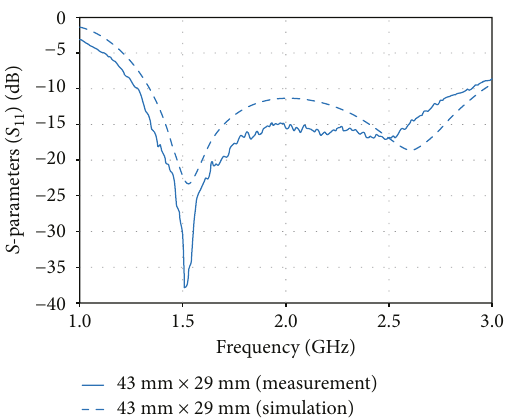
11 of foldable Figure 8: Simulated S -parameters: S with di ff erent lengths.